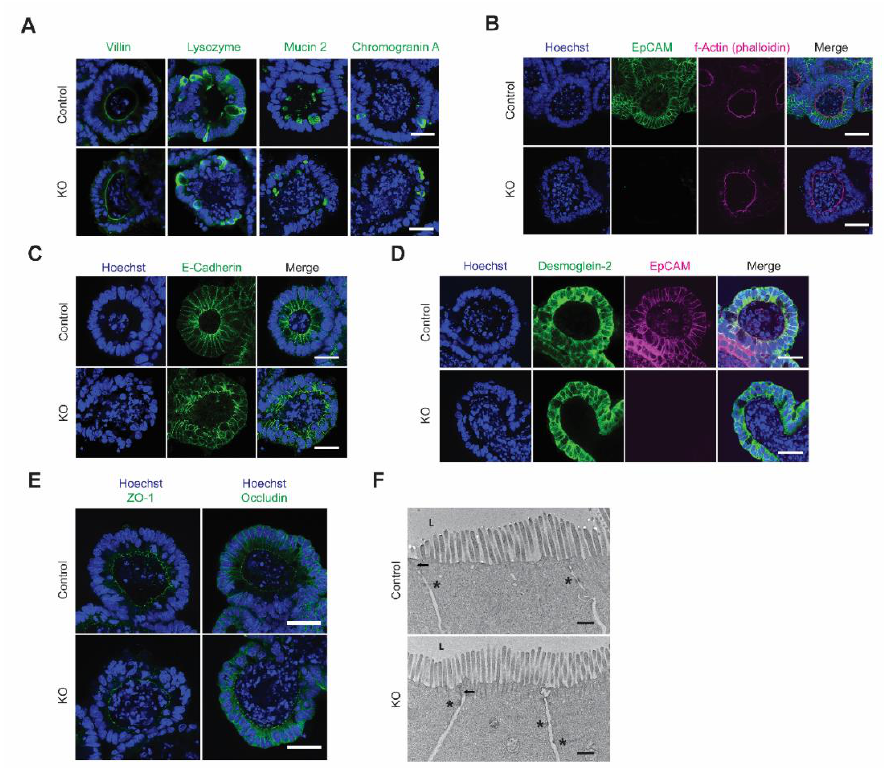
Figure 2. Differentiation, cell polarity and intercellular junctions in EpCAM-deficient organoids. ( A ) Differentiated intestinal epithelial cell (IEC) expressing villin (enterocytes), lysozyme (Paneth cells), mucin 2 (goblet cells) and chromogranin A (enteroendocrine cells) developed in control and KO organoids. Specific staining (green). Bars = 25 μ. ( B ) Localization of actomyosin cytoskeleton in control and KO organoids. EpCAM (green); phalloidin (pink). Bars = 25 μ. ( C ) Detection and localization of E-cadherin in control and KO organoids. E-Cadherin (green). Bars = 25 μ. ( D ) Expression and localization of desmoglein-2 and EpCAM in control and KO organoids. Dsg-2 (green); EpCAM (pink). Bars = 25 μ. ( E ) Expression and localization of ZO-1 and occludin in control and KO organoids. Specific staining (green). Bars = 25 μ. ( F ) Transmission electron micrographs of control and KO organoids. Arrows indicate tight junctions and asterisks designate desmosomes (L = bud lumens). Bars = 500 n. Nuclear counterstaining, Hoechst 33342 (blue) in ( A – E ).